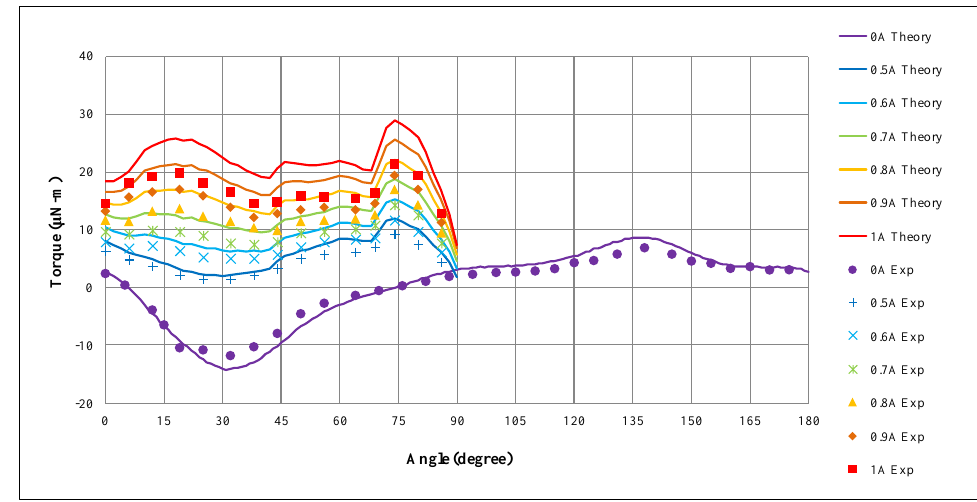
Figure 17. Theoretical and experimental torque-angle curves of the single-phase switched reluctance motor.